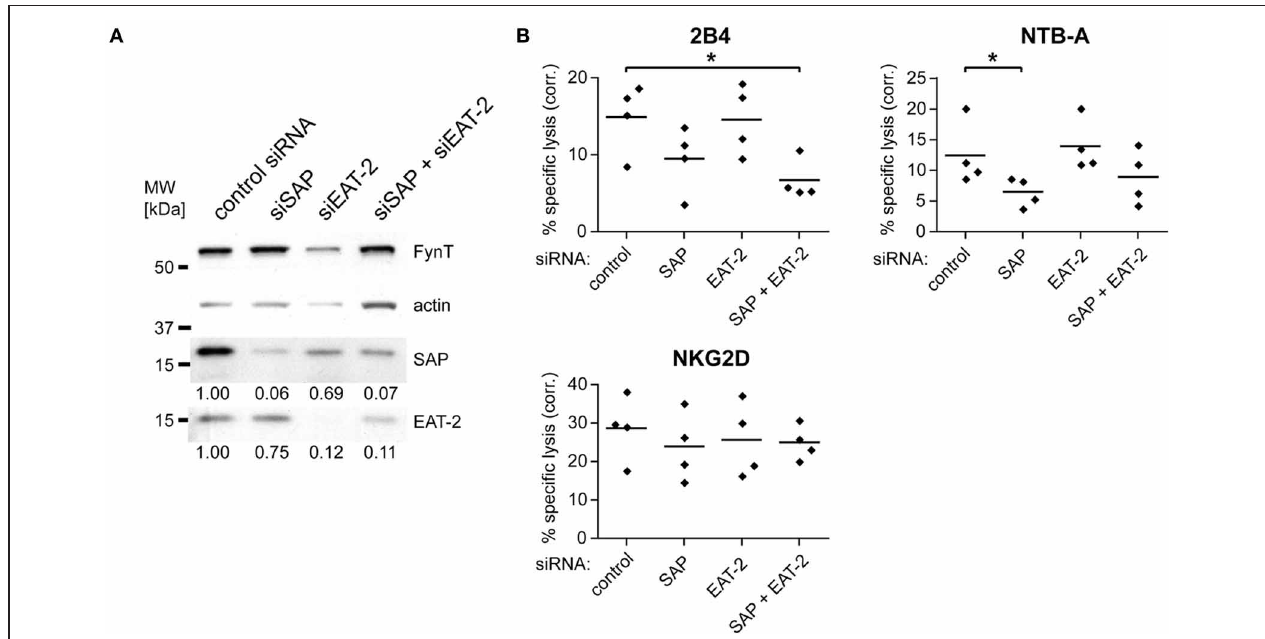
FIGURE 1 | 2B4 and NTB-A-mediated cytotoxicity is dependent on the expression of SAP, but not EAT-2 in primary human NK cells. IL-2-activated primary human NK cells were transfected with control siRNA, siRNA against SAP, against EAT-2 or both. (A) The knockdown was confirmed 48h later by Western blotting of whole cell lysates. The numbers below the lanes indicate relative signal intensity. The values were normalized to the respective actin signal and the value for the control siRNA sample was set to 1. (B) The functional consequence of the decreased expression of the